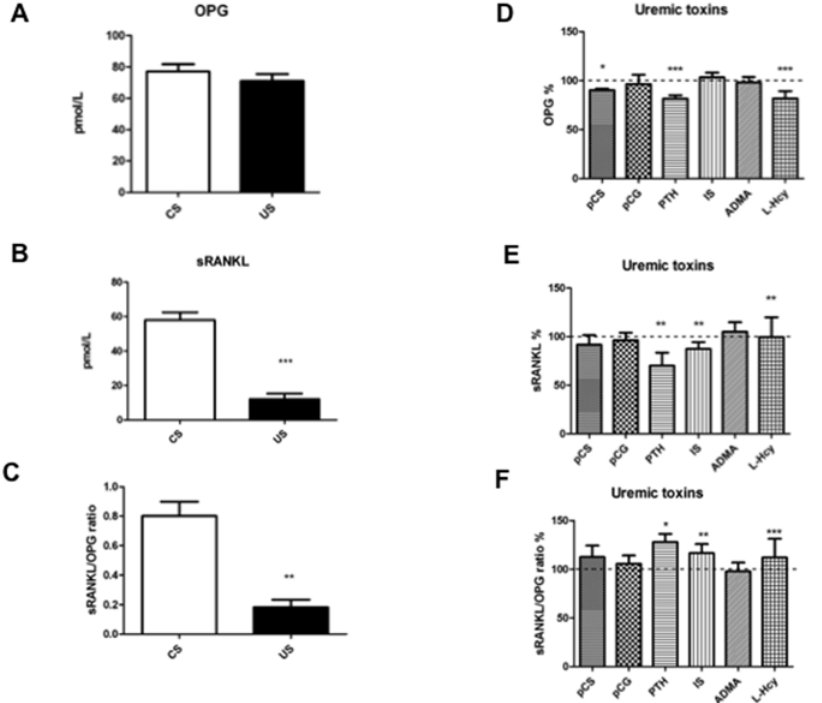
Figure 3. OPG, sRANKL and their ratio in response serum from uremic patients, and the effects of individual uremic toxins. OPG (panel A), sRANKL (panel B) and their ratio (panel C) were measured in hMSC cell medium at 3 days after induction of osteogenic differentiation in the presence of uremic serum (US), compared to control serum (CS). Another set of experiments was performed by inducing osteogenic differentiation in hMSCs cultured in the presence of control serum added with the indicated uremic toxins (pCS, p-cresylsulfate; pCG, p-cresylglucuronide; PTH, parathyroid hormone; IS, indoxyl sulfate; ADMA, asymmetric dimethylarginine; Hcy, homocysteine), compared to control serum alone. Panel D: OPG; panel E: sRANKL; panel F: sRANKL/OPG ratio. * p < 0.05, ** p (cid:1) 0.01, *** p < 0.001.